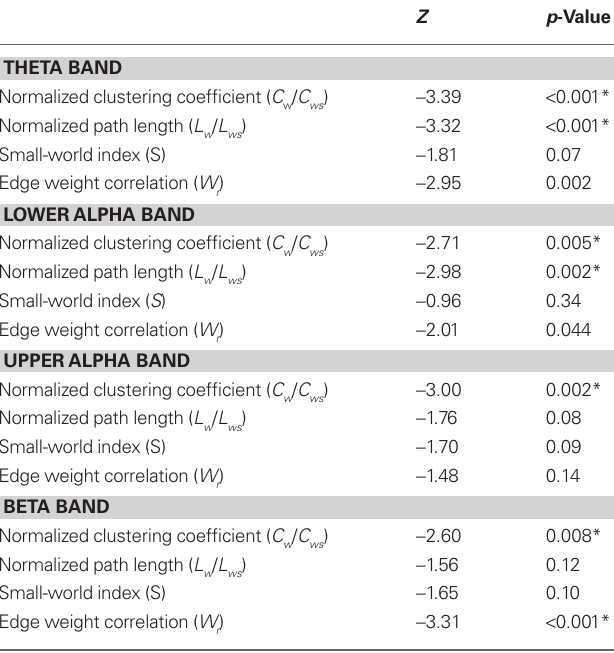
Table 1 | Test statistics of all comparisons between network characteristics before and after injection of